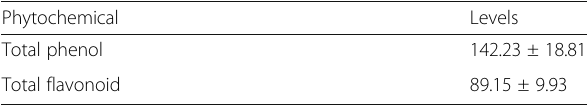
Table 1 The total phenol and total flavonoid contents of the methanolic extract of Jatropha tanjorensis